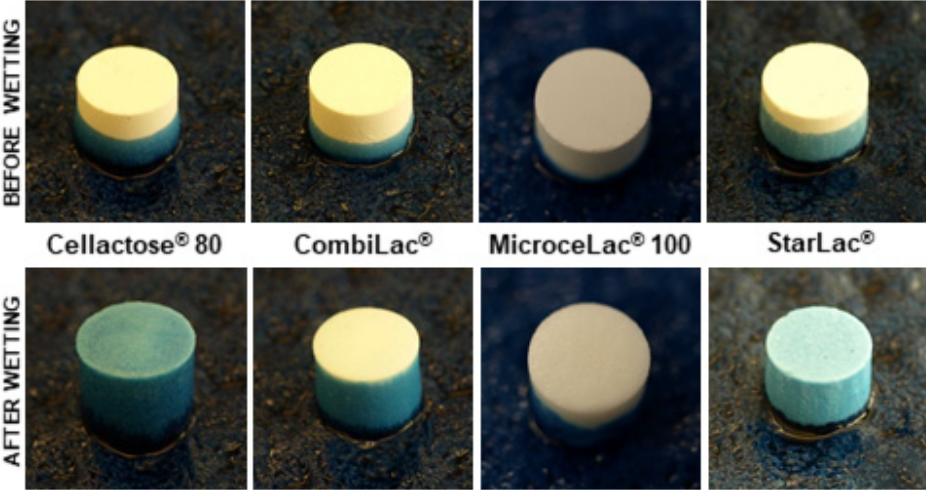
Figure 8. Tablets prepared using a compression pressure of 78 MPa before ( t = 0 s) and after complete wetting (T2).